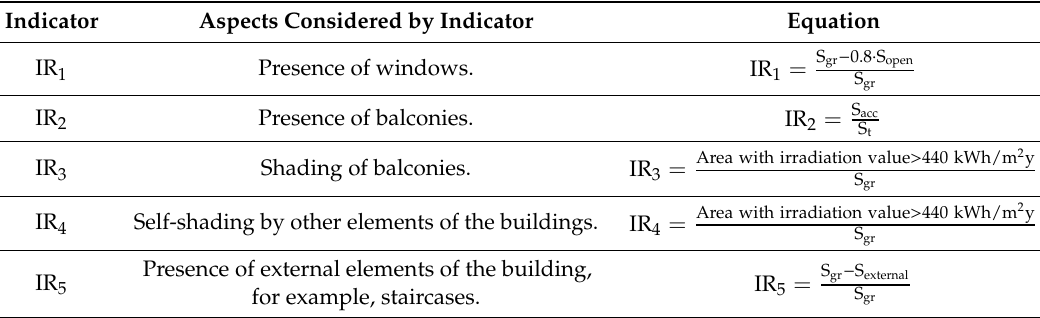
Table 6. Description and calculations of the reduction factors.